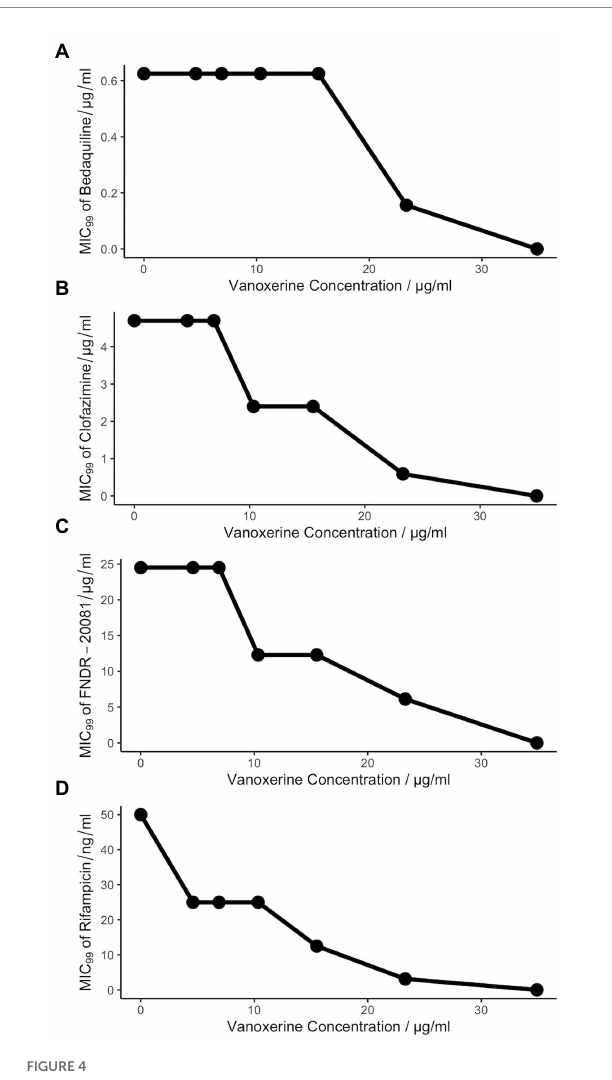
FIGURE 4 Vanoxerine does not potentiate the effects of other